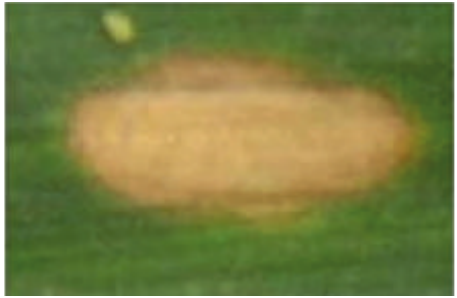
Figure 2: Maize leaf disease original image.